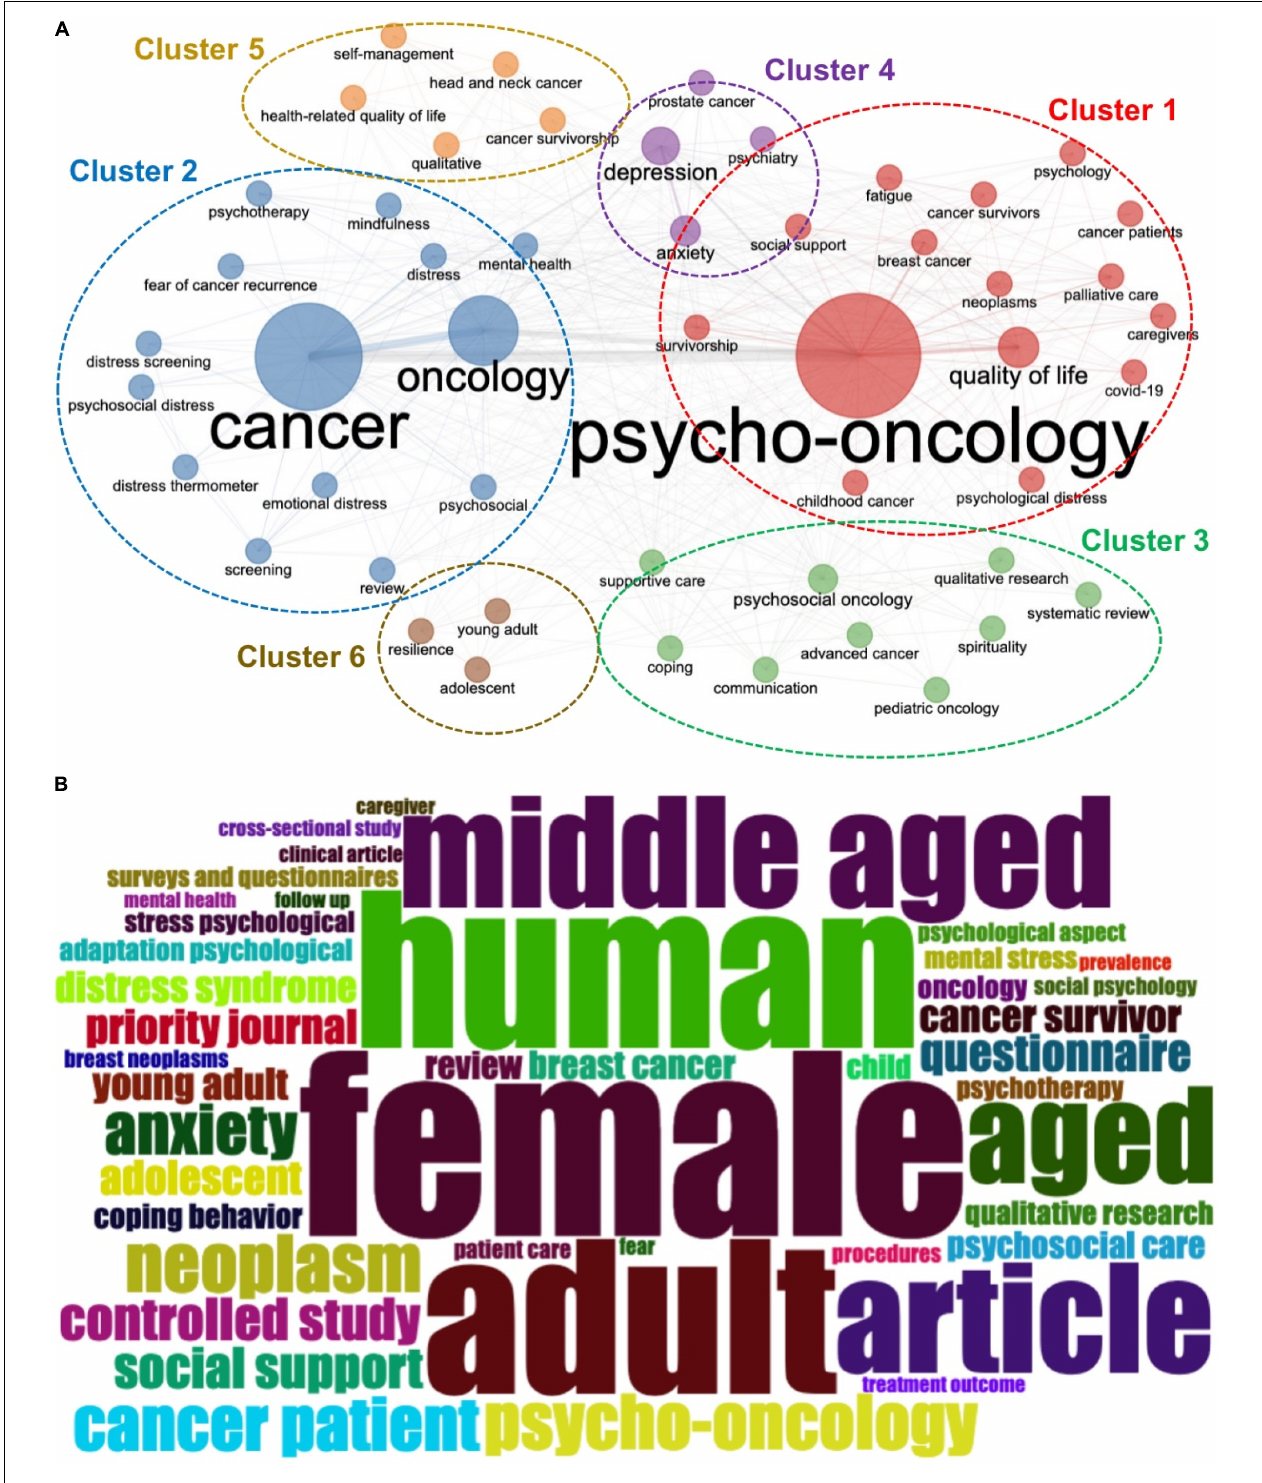
FIGURE 9 | (A) Frequently used author’s keywords, (B) KeyWords Plus WordCloud map.